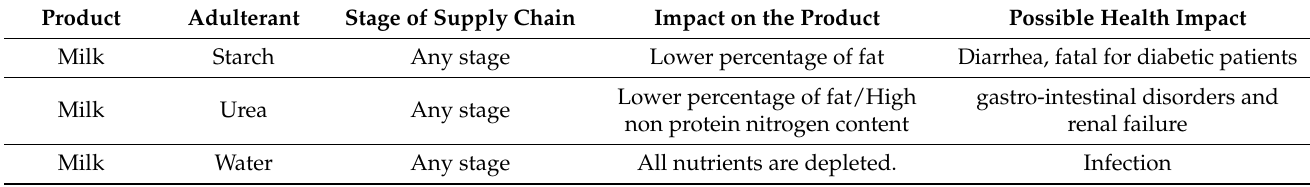
Table A2. Type of adulterants in milk and their impacts on health and nutrition.